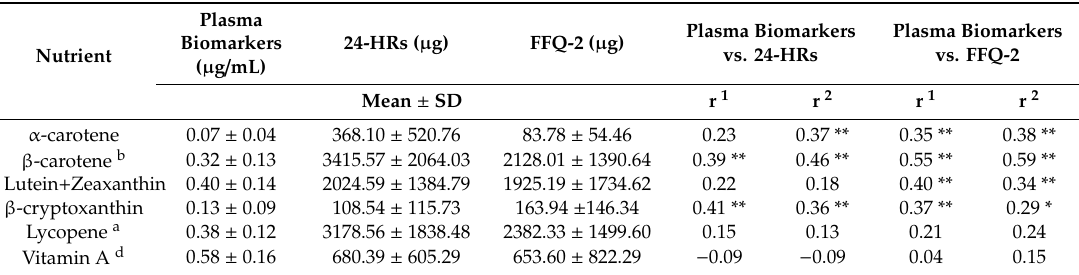
Table 3. Spearman correlation coe ffi cients for diet–plasma carotenoids and vitamin A with specific intake estimated from 24-HRs and with FFQ-2 ( n =